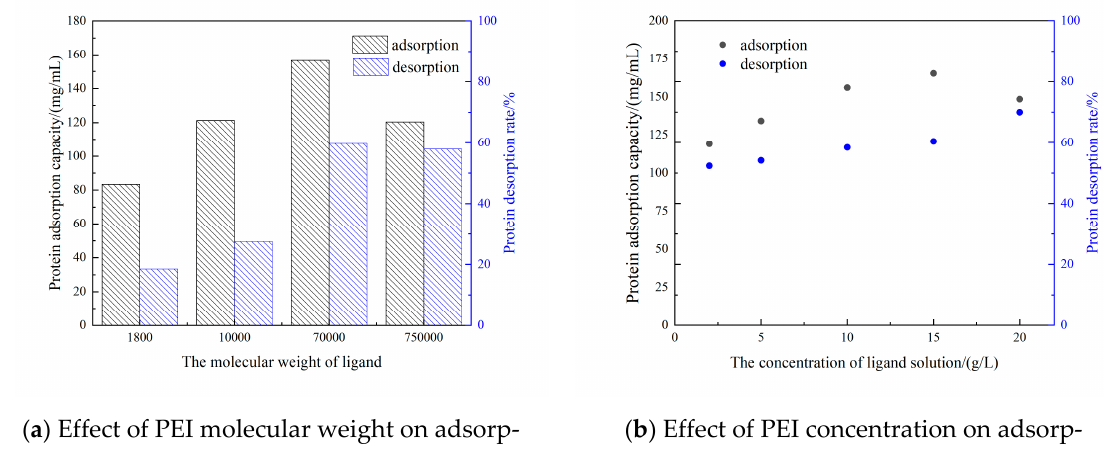
Figure 8. Effect of the ( a ) molecular weight and ( b ) concentration of ligand on the protein adsorp- tion/desorption performance of the MA (pH poly = 8.7, T poly = 25 °C, C PEI = 15 g/L/ M PEI = 70,000).